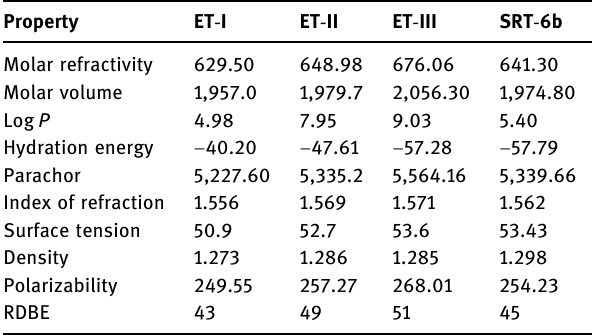
Table 1: Molecular attributes and QSAR properties of the ETs and SRT -